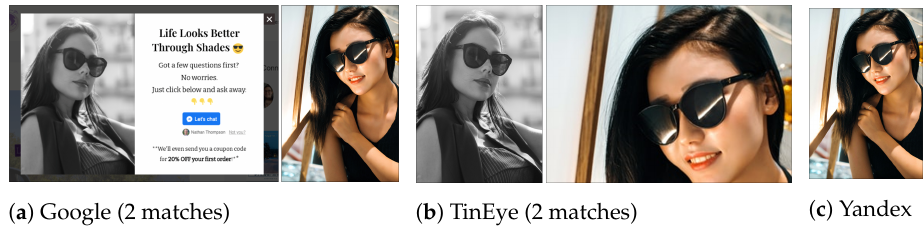
Figure 3. Image search results of Figure 2a by Google [7], TinEye [9], and Yandex [8]. We additionally tried with Bing, but did not obtain any results.